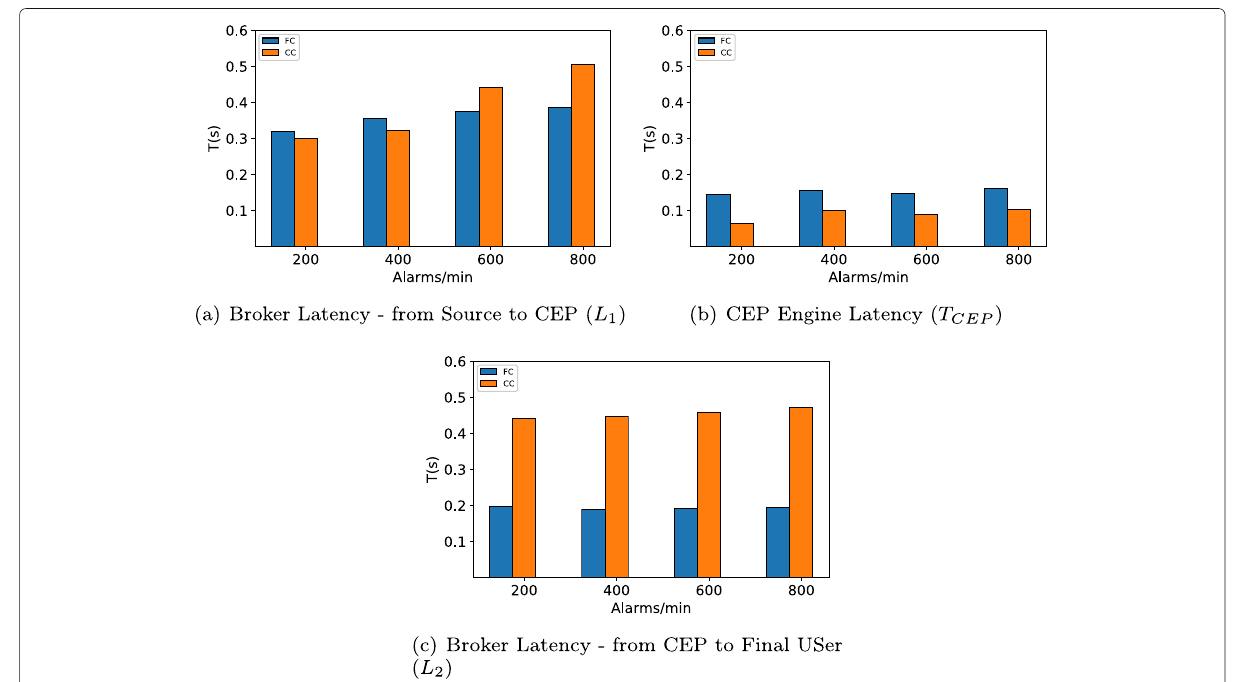
Fig. 10 Average Latency Breakdown - Fog Computing (FC) vs. Cloud Computing (CC) Architectures